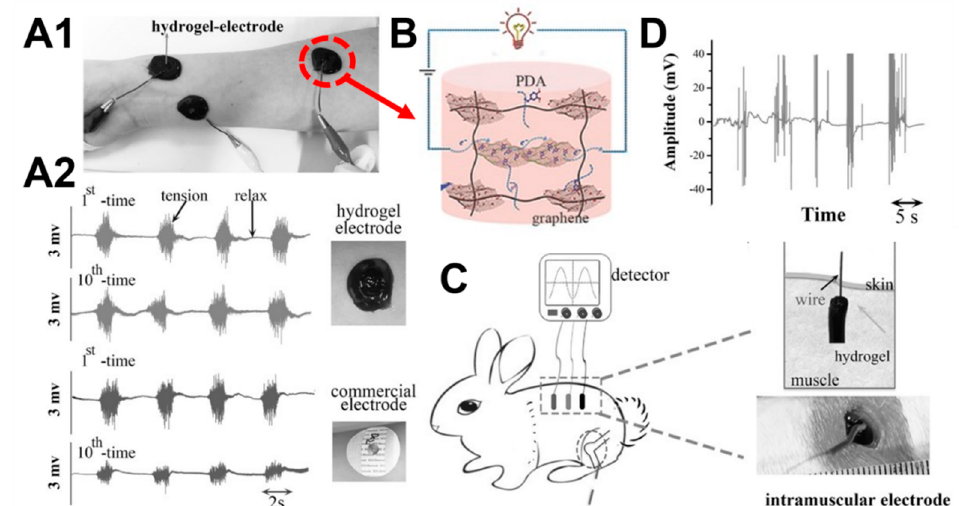
Figure 12. Conductive hydrogel as self-adhesive electrode biosensors. ( A1 ) The hydrogel self-adhered to human arm skin and detected the electromyographic signals. ( A2 ) Comparisons of electromyography recorded by hydrogel electrodes and commercial electrodes after ten cycles of usage (adhere-strip). ( B ) The schematic diagram of the chemical structure of conductive hydrogels. ( C ) Three hydrogel electrodes were implanted onto the dorsal muscle, and the wires from the electrodes were transcutaneously connected to the signal detector. ( D ) Example of electromyography recorded by the implanted hydrogel electrode biosensors from the muscle when the target rabbit was exposed to external stimuli (the animal experiments were performed in accordance with protocols approved by the local ethical committee and laboratory animal administration rules of China). Reprinted with permission [37]. © 2016, Wiley-VCH (Weinheim, Germany).